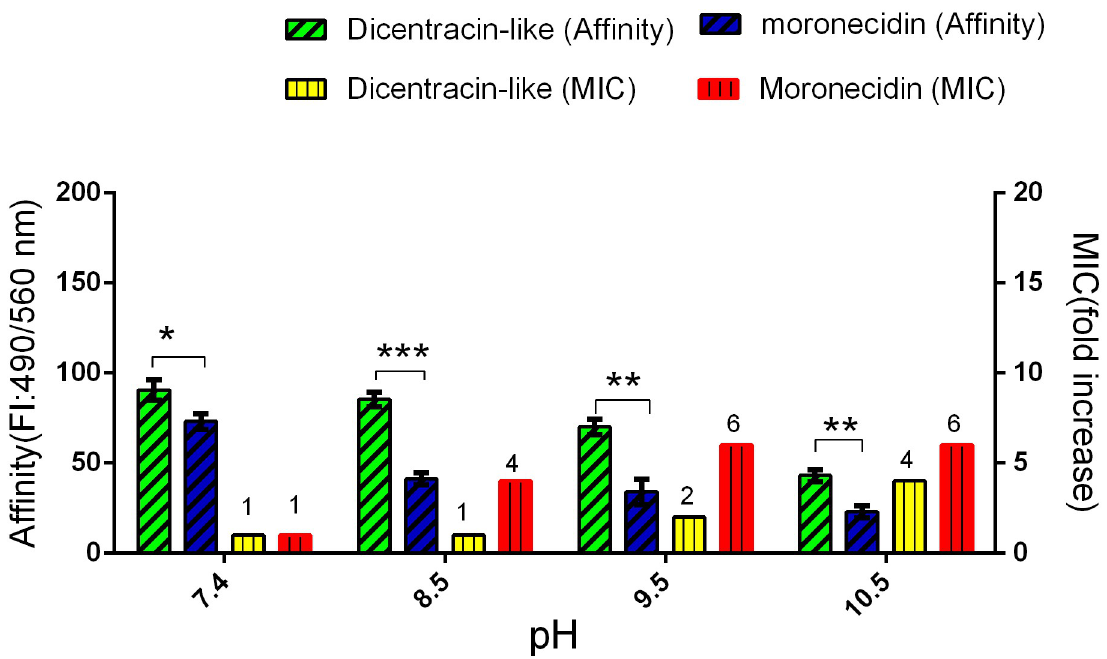
Fig 4. Evaluation of the pH effect on the AMPs binding affinity to E . faecalis and their MIC. Binding affinity of moronecidin and dicentracin-like to bacteria was measured with a cell based fluorimetric ELISA. Fluorescence intensity of wells were measured on a microplate reader at excitation /emission (Ex/Em) = 490/560 nm. Data represent mean ± SD for three independent experiments. � P = 0.01, �� P = 0.002, ��� P �